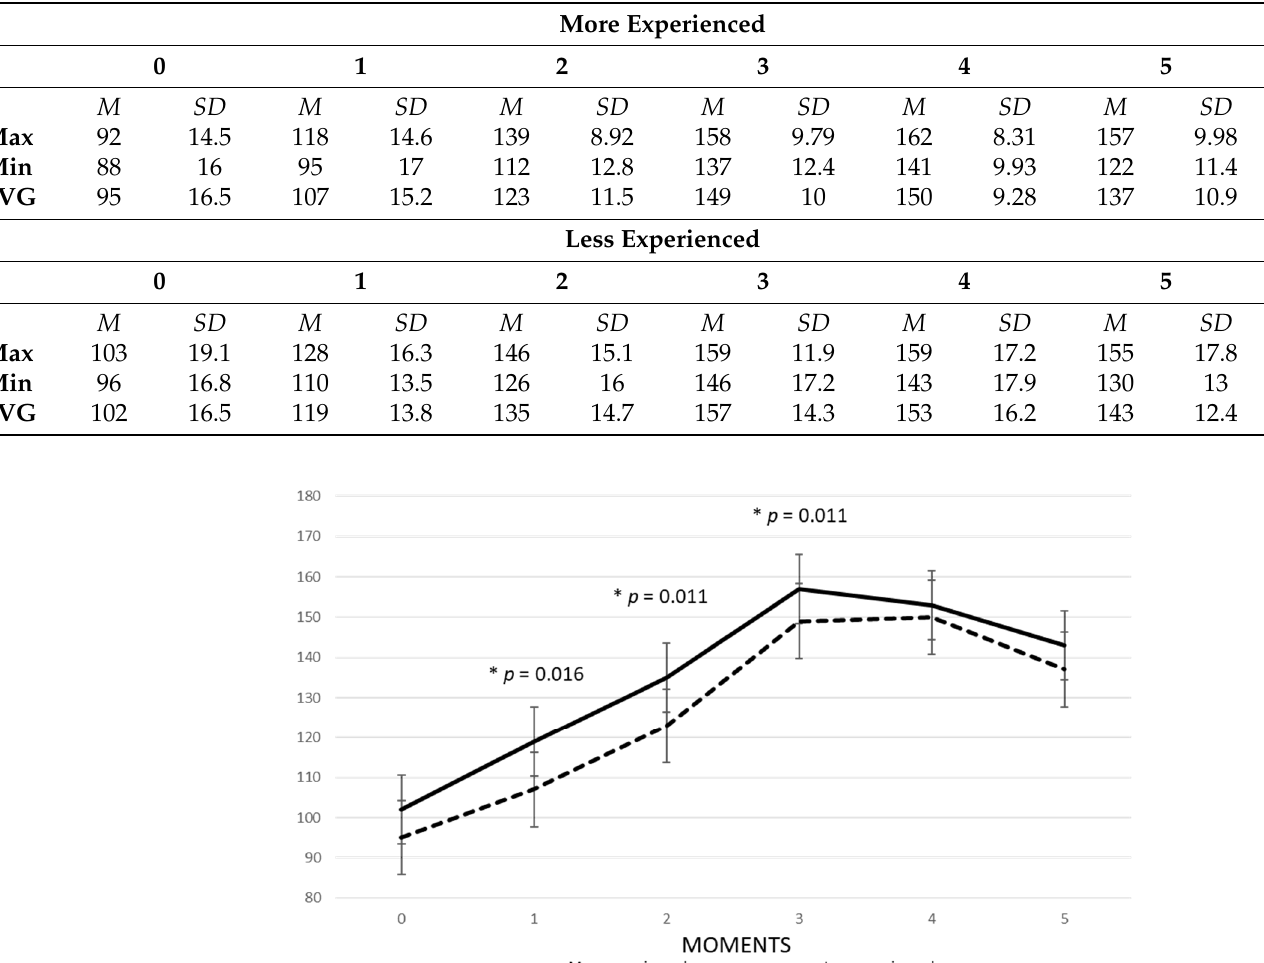
Table 2. HR at the moments of a jump in relation to level of experience.